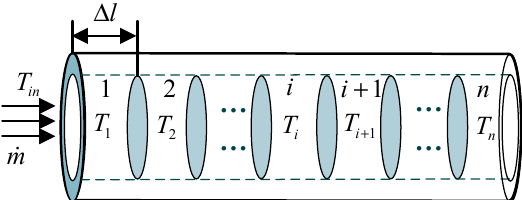
Figure 3. Schematic diagram of pipeline discrete.